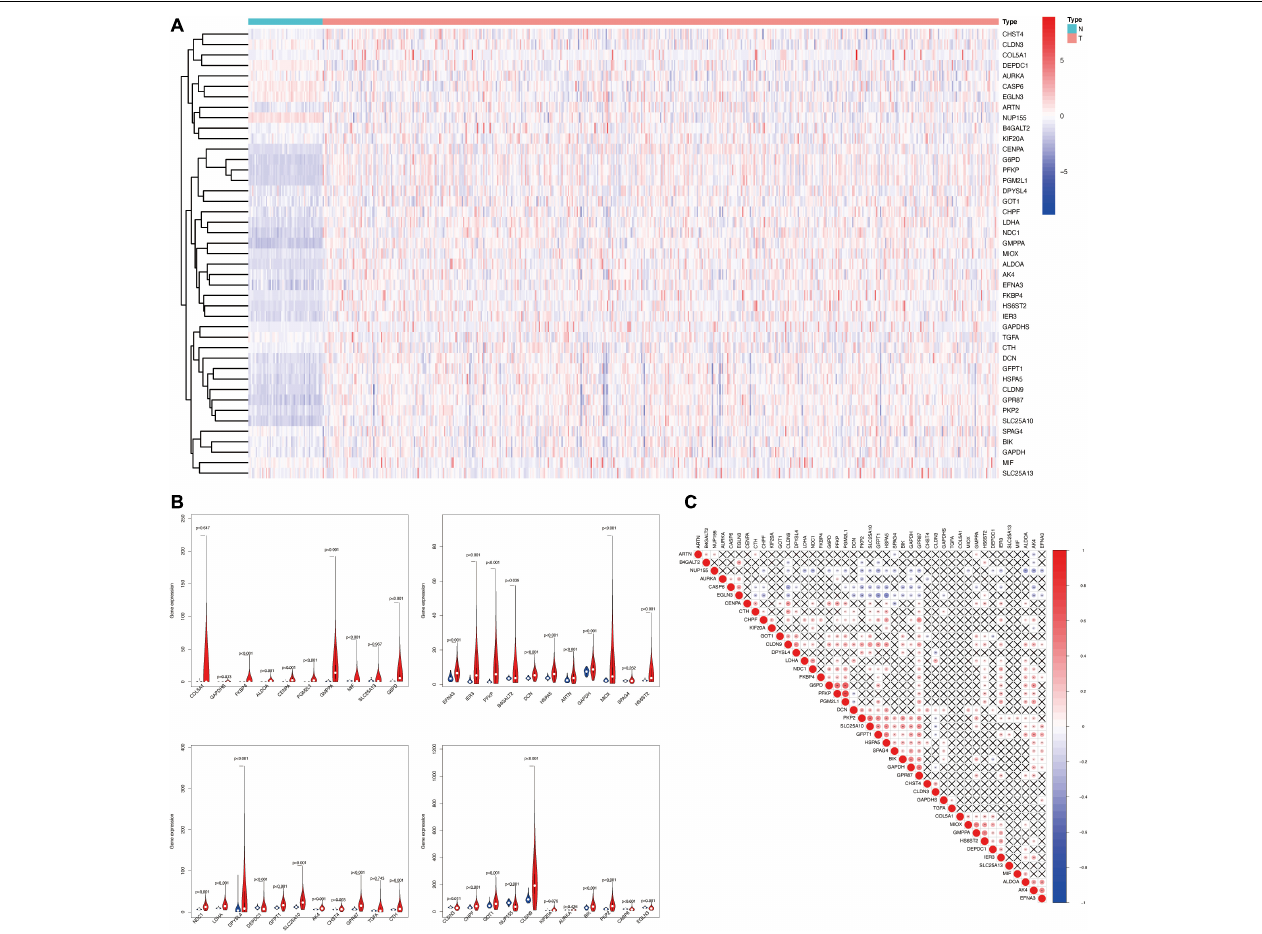
FIGURE 3 | The landscape of 43 glycolysis-related genes in LUAD. (A) The expression levels of 43 glycolysis-related genes in LUAD. The red color means tumor tissues and the blue color means the non-tumor tissues. Genes are in rows; samples are in columns. (B) Vioplots of 43 glycolysis-related genes in LUAD, p < 0.05 was considered to be statistically significant. Blue is normal tissues and red is tumor tissues. (C) Spearman correlation analysis of 43 glycolysis-related genes in LUAD. The red color means positive correlation and the blue color means negative correlation. LUAD, lung